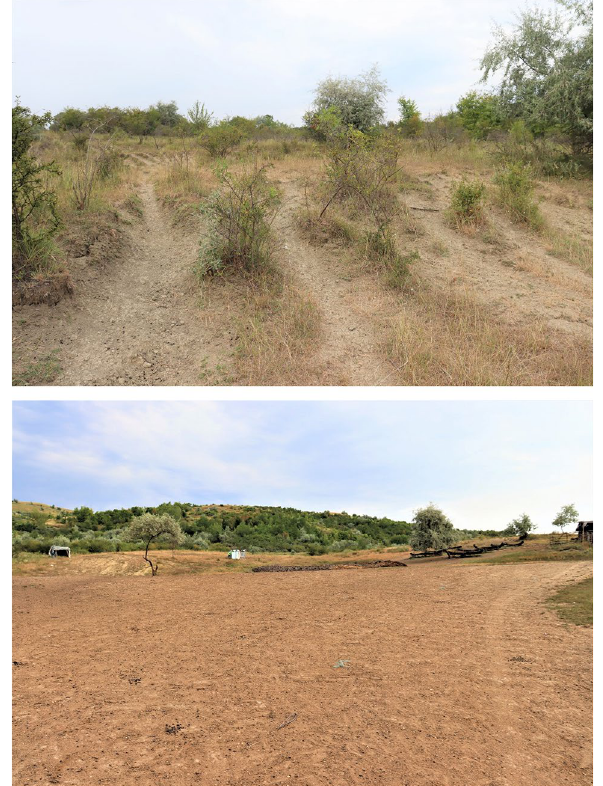
Figure 8. Sheet and linear grazing impact of SRs photos—near paddock (up/left) and trails (down/right) in the Curvature Subcarpathians (Romania); photograph taken by Gabriel MINEA on August 18th,